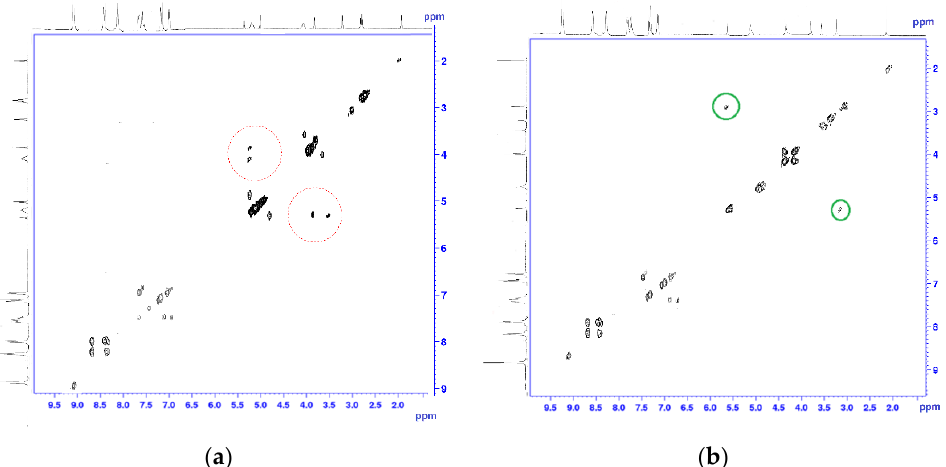
Figure 6. 1 H– 1 H 2D ROSY NMR spectra of the complexes Co(III)P2-(L2) ( a ) and Co(III)P2-(L3) ( b ) in D 2 O/H 2